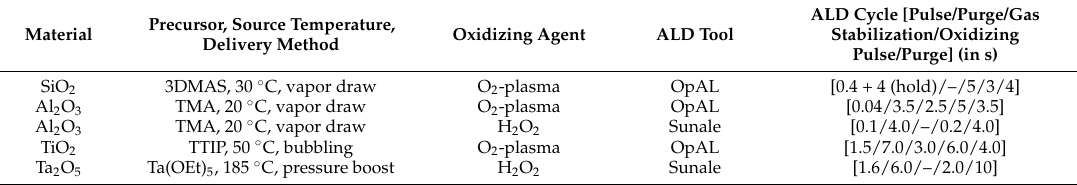
Table 1. Process parameter for depositing SiO 2 , Al 2 O 3 , TiO 2 and Ta 2 O 5 ALD thin films.